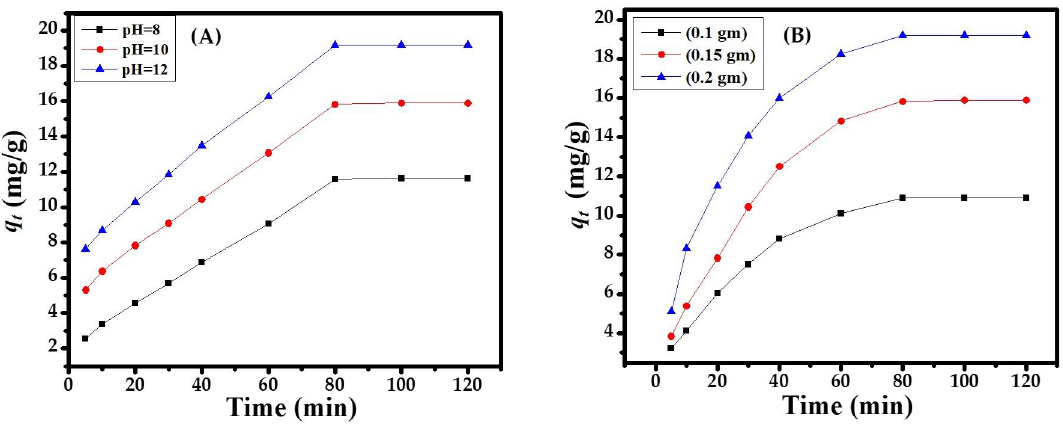
Figure 3. ( A ) Effect of pH on the adsorption of dye; ( B ) Effect of the adsorbent dose on dye adsorption at pH